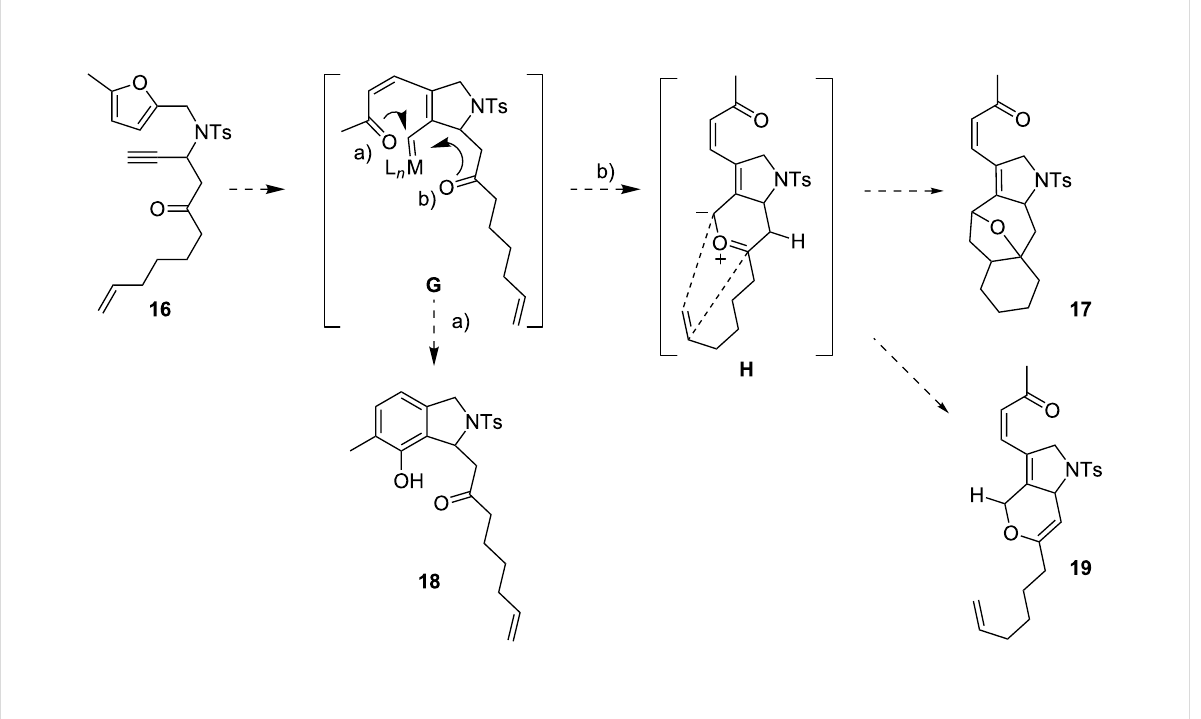
Scheme 7: Potential products of an intramolecular trapping experiment with substrate 16 .